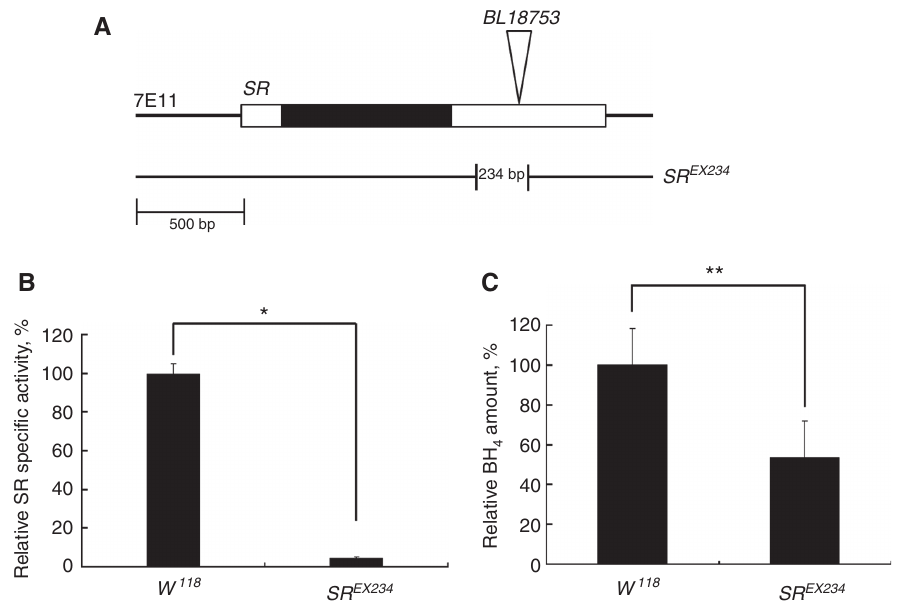
levels in SR Ex234 mutants. (A) Genomic structure of SR . The black box and Figure 1: Specific activity of sepiapterin reductase (SR) and BH 4 white boxes indicate coding exon and untranslated regions (UTR), respectively. The BL18753 P -element was imprecisely excised to gener- ate SR Ex234 . SR Ex234 was a 234-bp deletion, and the excised region is represented by vertical lines. (B) Relative SR specific activity. NADPH- dependent SR specific activity in 3-day-old male flies. (C) Relative BH levels in 3-day-old male flies. Error bars showing the standard devia- 4 tion (SD) of three independent experiments. Asterisks indicate significance by Student’s t-test (*p < 0.0001, **p <